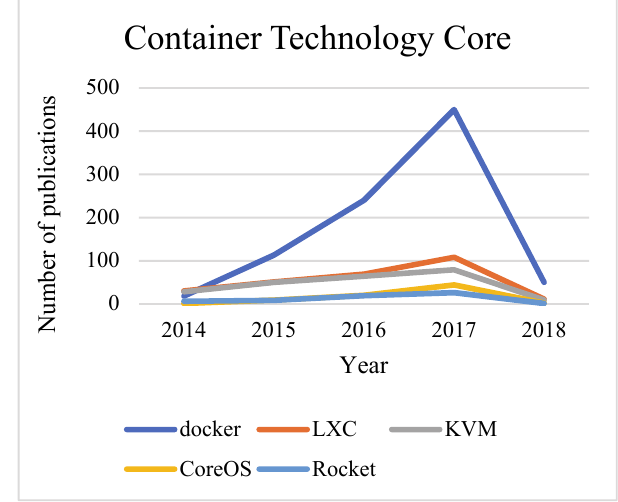
Fig. 5. Container Technology Core – Layers 2, 3, and